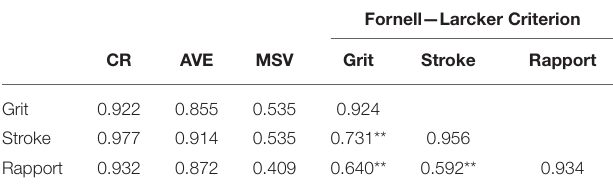
TABLE 3 | Reliability and validity of the